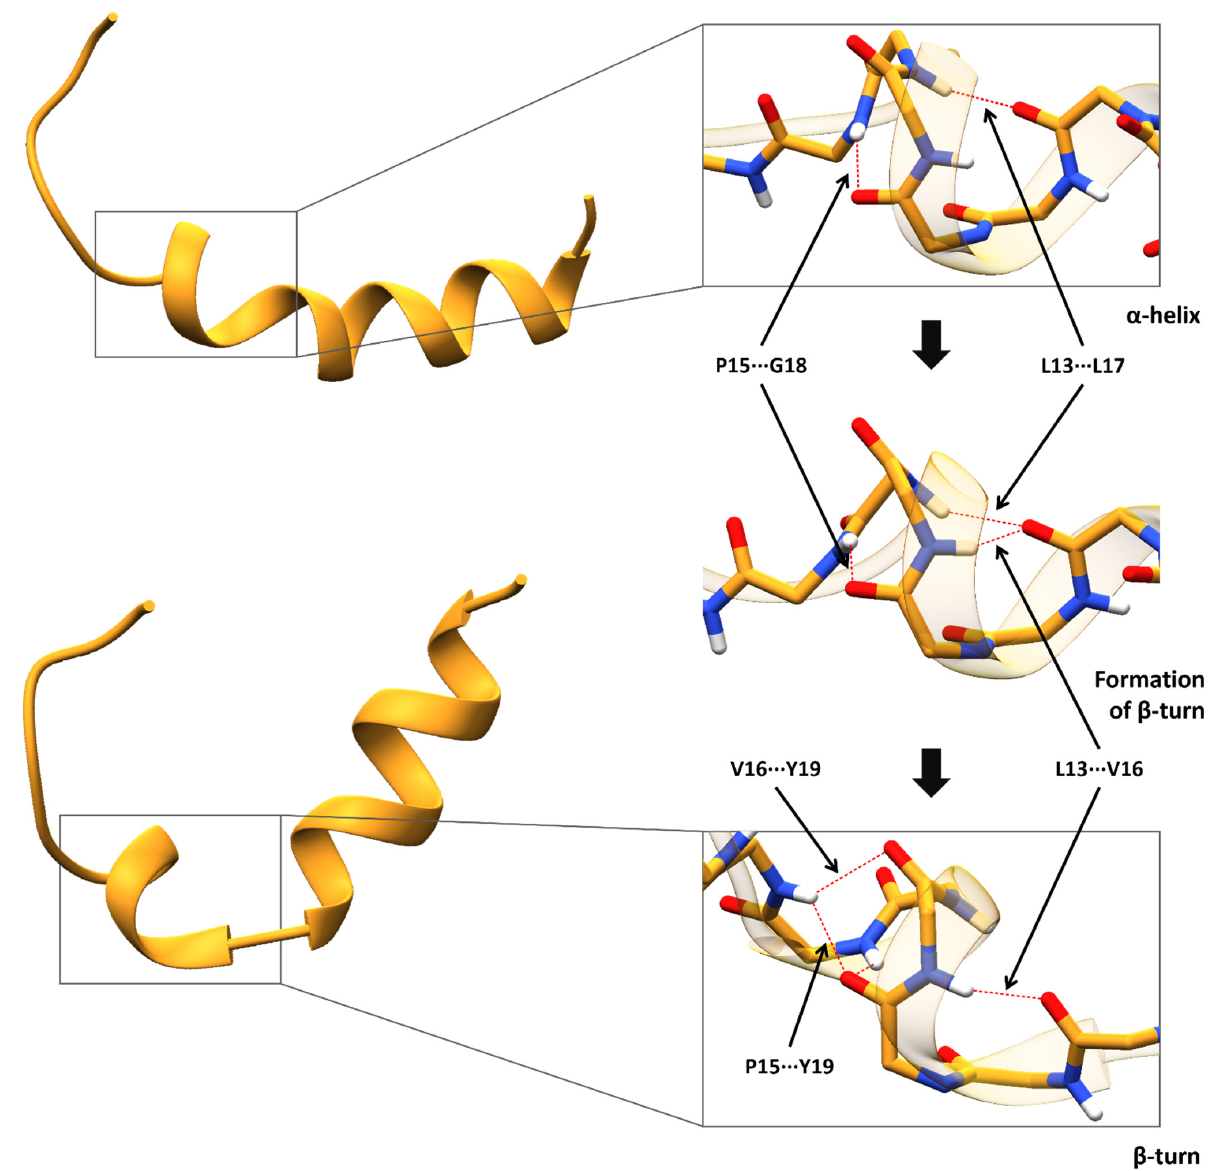
Figure 6. Schematic representation of the hydrogen bonds responsible for the Val-MTS helix break- down. The collapse of the hydrogen bond between Leu13 and Leu17 seems to be responsible for the conversion of Val-MTS to a β -turn at residue 13, which initiated the breakdown of the α -helix. Β - turn is defined as an i, i + 3 segment possessing a hydrogen bond between the CO group of residue i and the NH group of residue i + 3.